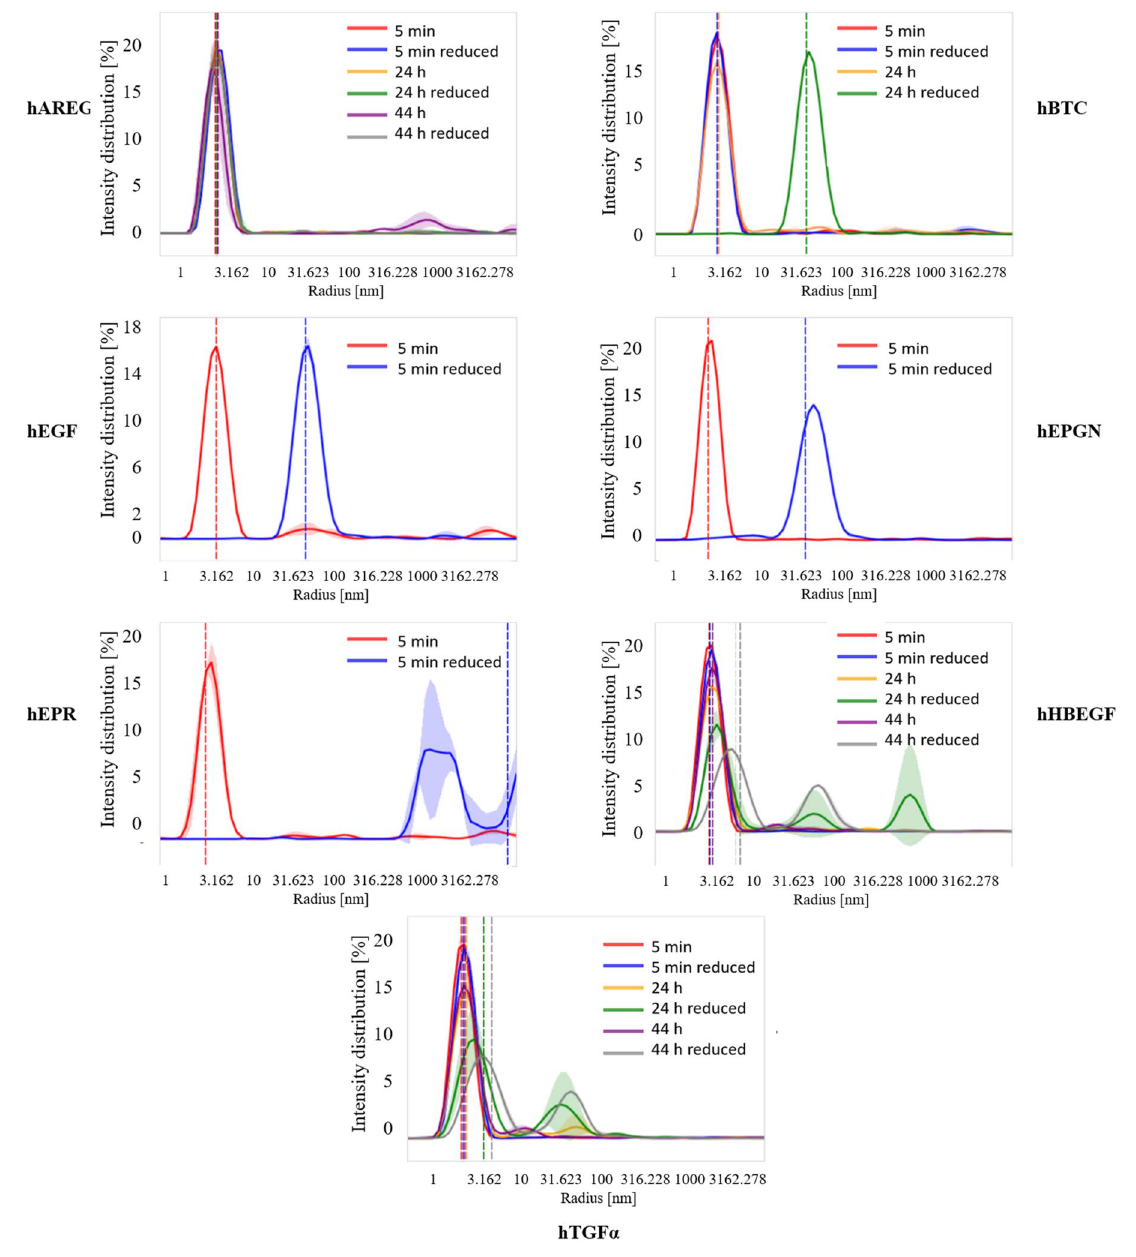
Figure 3. Radius size and aggregation analysis by DLS. Profiles of radius size distribution of the purified EGF growth factors under reducing and non-reducing conditions as determined by dynamic light scattering analyses. The dashed vertical lines represent the center of the cumulative radius of each sample. All assays were performed at 20 °C. Times and treatment are indicated in the figure. The graphics show the intensity distribution (%) as a function of particle radius